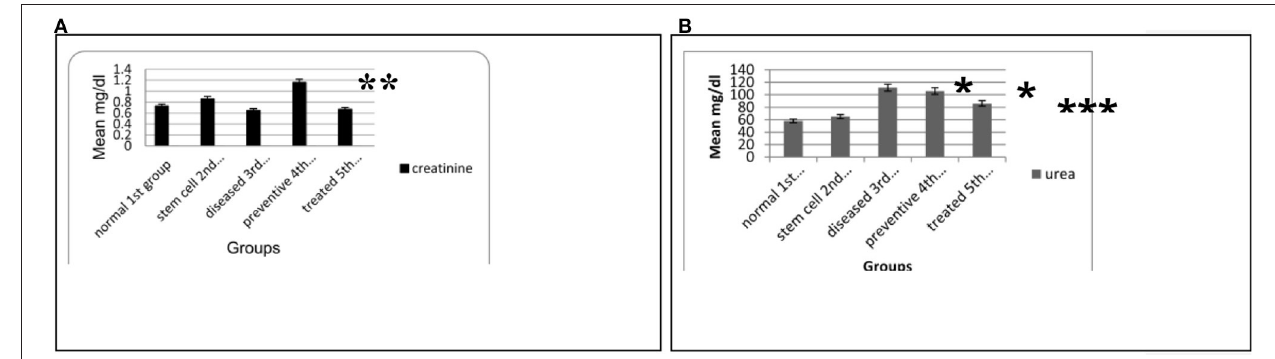
FIGURE 2 | (A) Means of SCr level in the blood serum for the different animal experimental groups. (B) Means of BUN level in the blood serum for the various animal experimental groups. Each data are the mean ± S.D using ANOVA, p < 0.05. *Significant compared to other groups, p < 0.05. **Significant compared to the normal and stem cell groups, p < 0.01. ***Significant compared to the diseased group, p < 0.05.